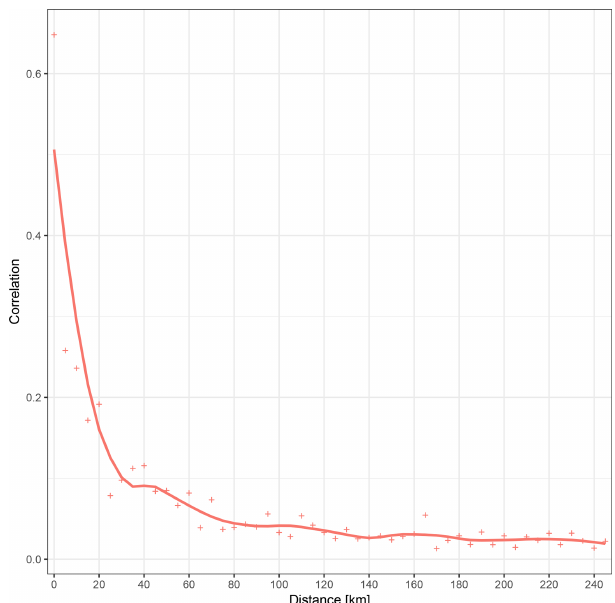
Figure 4. Observation error correlations estimated by Desroziers method as a function of separating distances for GNSS ZTDs inside AROME/Hungary’s domain. Local polynomial regression method was used to fit a smooth curve and the diagnostic was computed for the period of 15–31 May 2017.